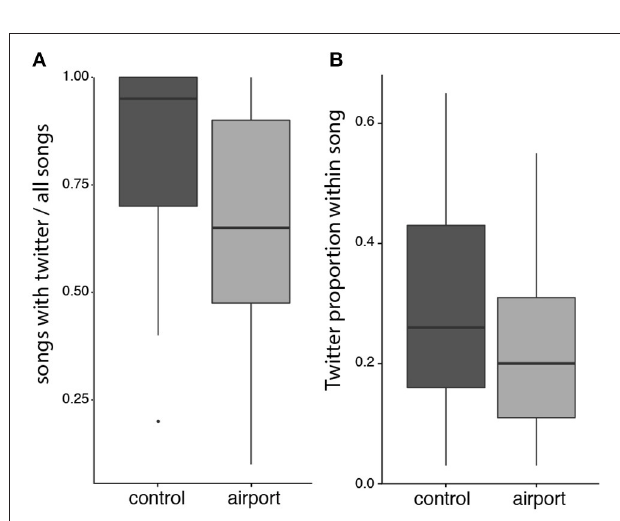
FIGURE 5 | Boxplots comparing (A) the proportion of songs with twitter out of the total number of songs analyzed per male, and (B) the proportion of twitter length within the song for the subset of songs that present twitter